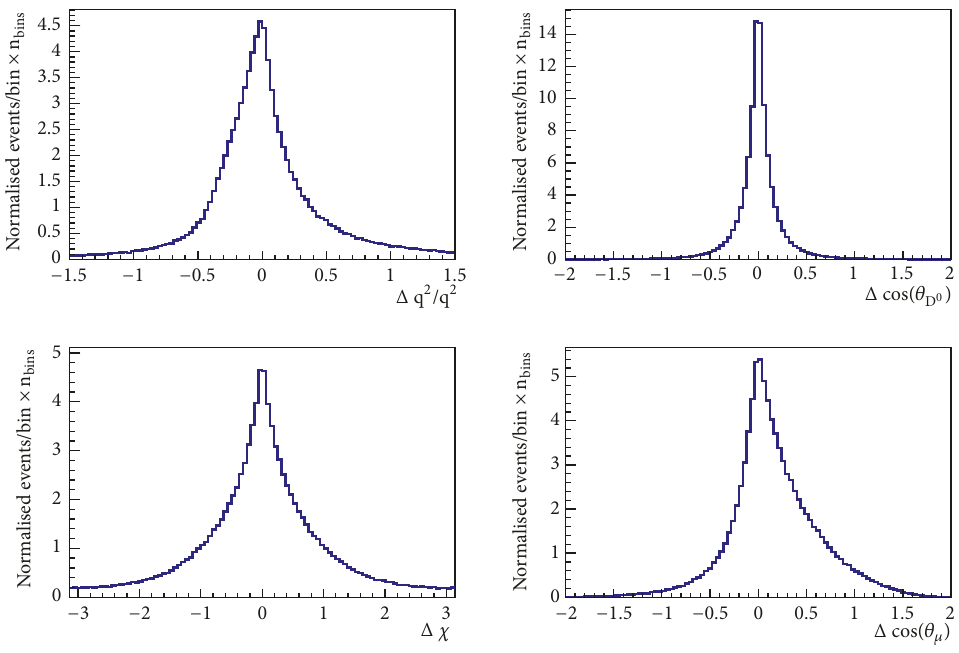
Figure 4: Resolution on the phase space variables for 𝐵 󳨀→ 𝐷 ∗+ 𝜇 − ] 𝜇 decays, obtained with equal velocity algorithm.